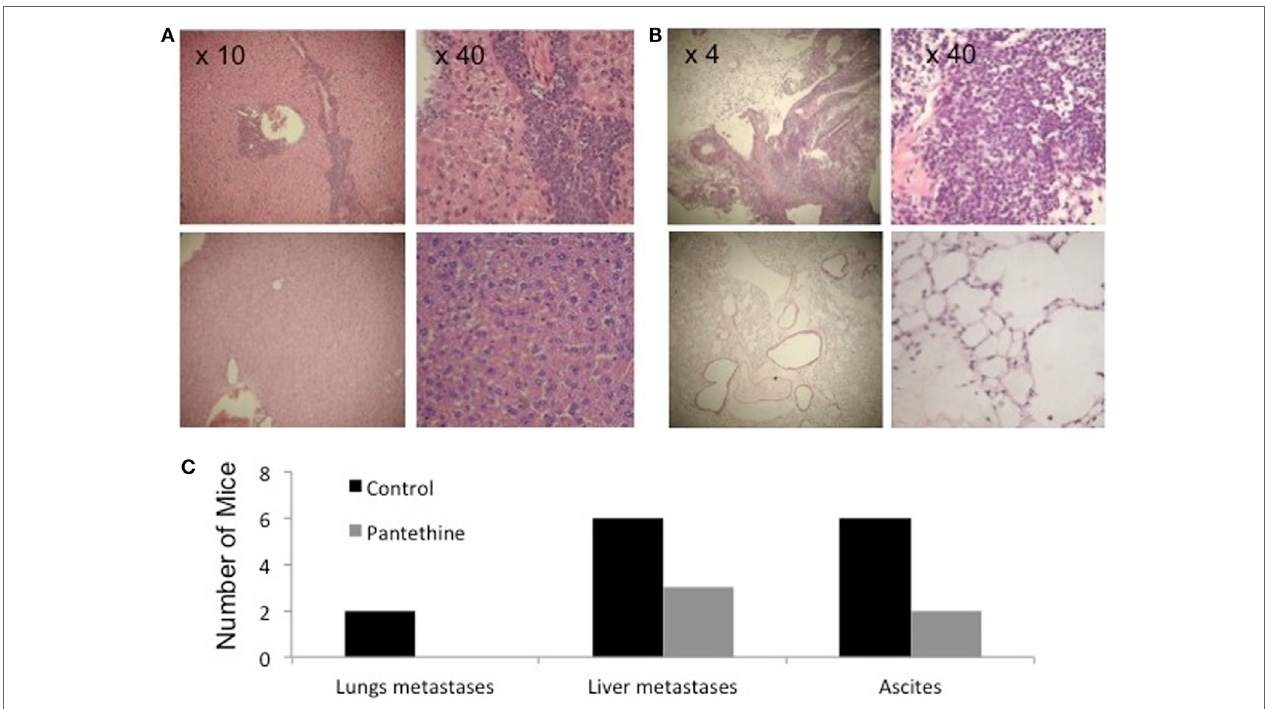
FigUre 3 | representative h&e stained sections of liver (a) and lungs (b) from a control mouse (top row) and a treated mouse (bottom row) . (c) Histogram representing the number of control and treated mice with metastases in the lungs, in the liver, and with ascites ( n = 7).